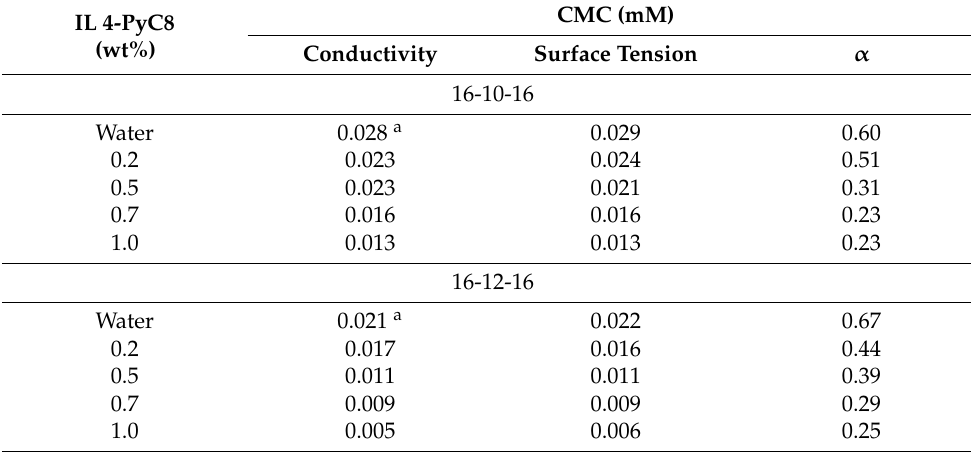
Table 1. Critical micelle concentration (CMC) and counter ion dissociation ( α ) of the gemini surfac- tants 16- s -16 with different contents (wt%) of the IL 4-PyC8 at 300 K.